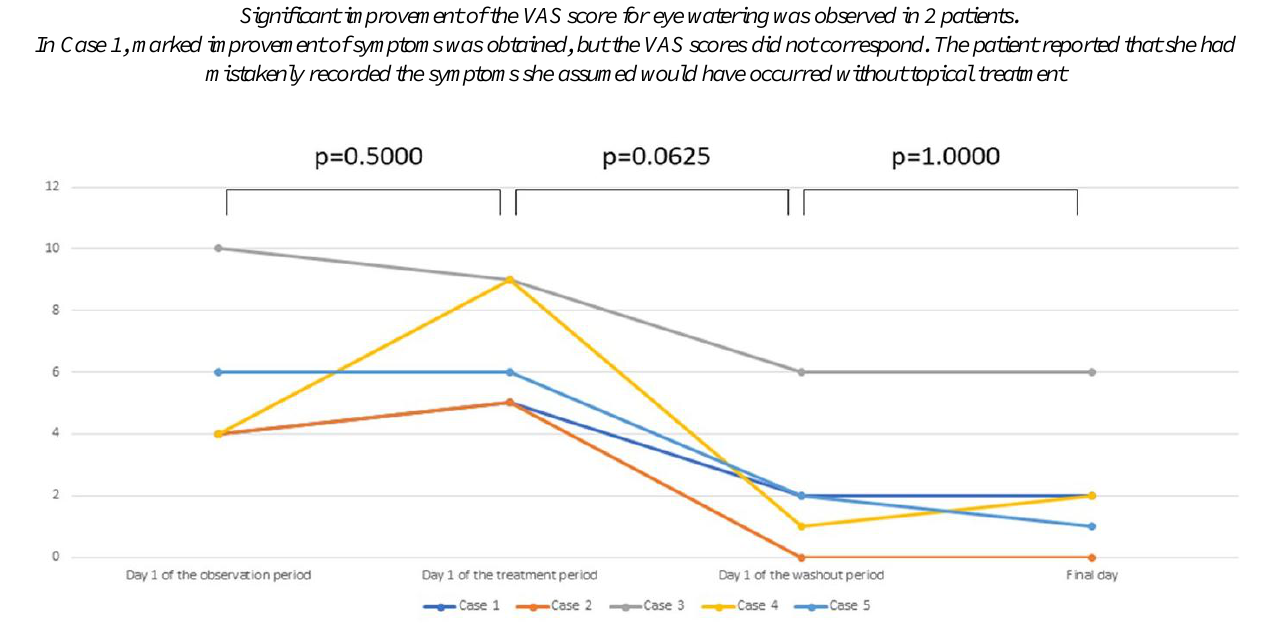
Figure 1 : Clinical findings. Scores from 0 to 3 were assigned for ophthalmological findings of the palpebral conjunctiva (congestion, swelling, follicles, papillae, giant papillae), bulbar conjunctiva (congestion, edema), limbus (Trantas spots, swelling), and cornea (epithelium), and the total score was calculated for each of the right and left eyes. Improvement of clinical findings was observed after treatment (p=0.0625, Wilcoxon signed rank test). There was no exacerbation of findings in the washout